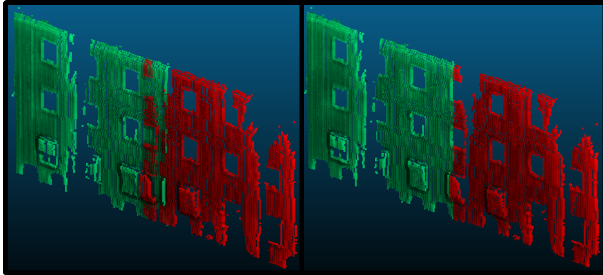
Figure 4. Excerpt of the transformed point cloud in the transi- tion between two segments without interpolation (left) and with interpolation (right).